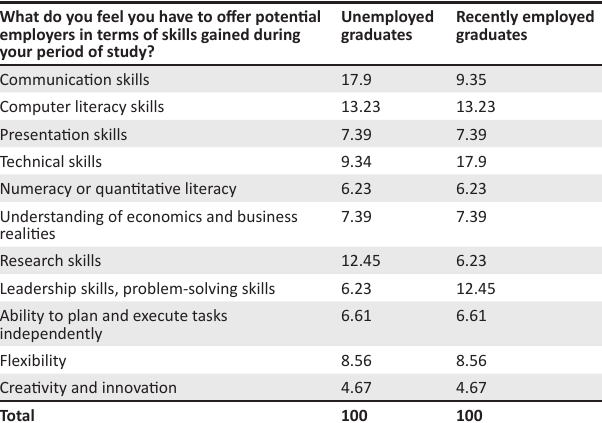
TABLE 3: Perceived skills acquired ( %